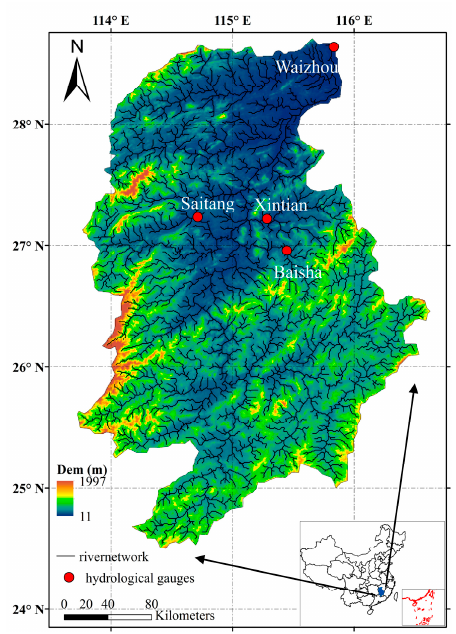
Figure 1. Domain of Ganjiang River Basin, streams, basin outlet station, and inner basin hydrological stations used in this study.